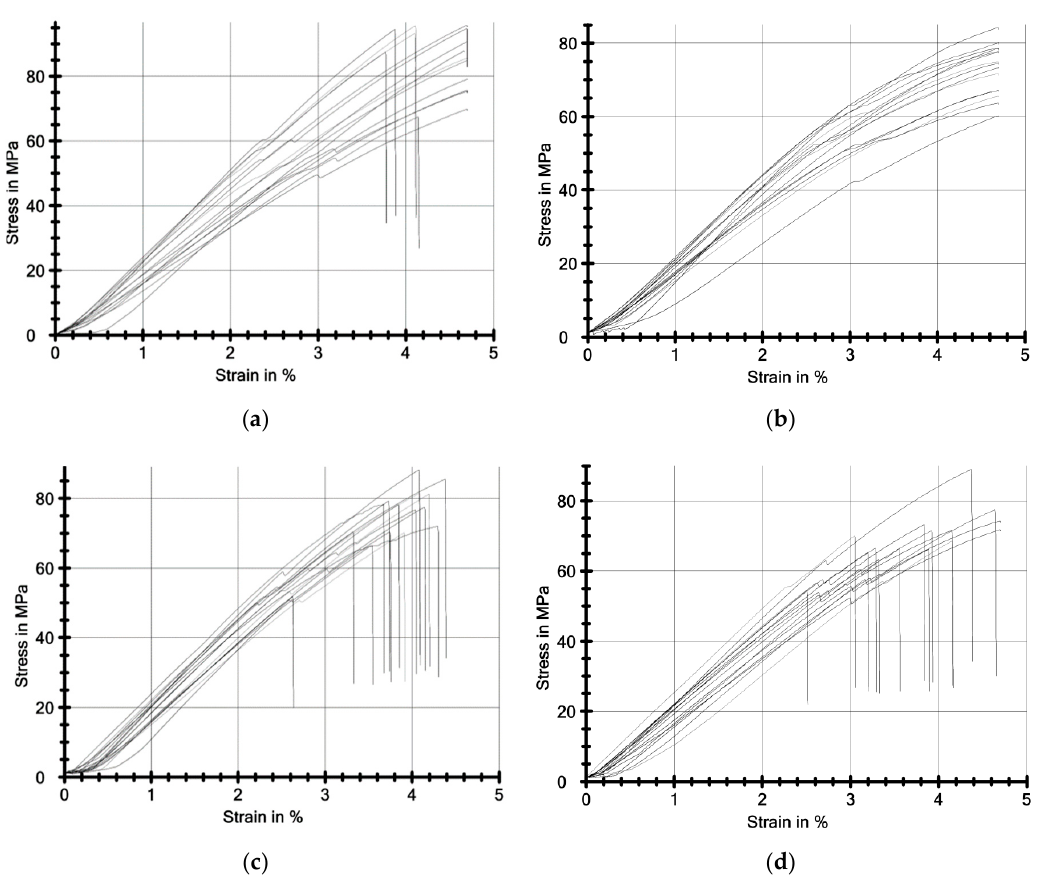
Figure 7. Graphs from the three-point bending test (stress-strain). ( a ) Material 1A, ( b ) Material 2A, ( c ) Material 3A, ( d ) Material 4A.